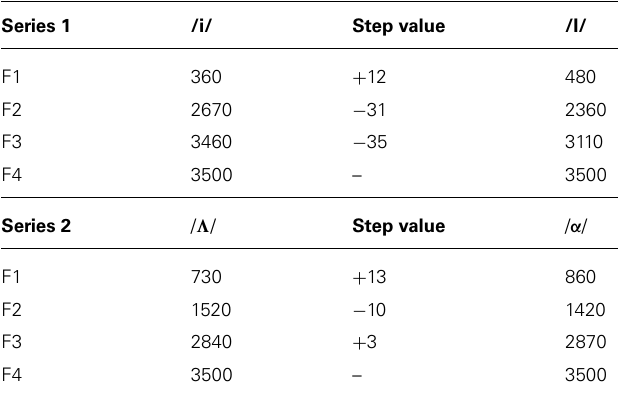
Table 2 | Formant values and step changes to create the vowel series (/i/ to /I/ and / (cid:2) / to / α /) with the Klatt synthesizer.